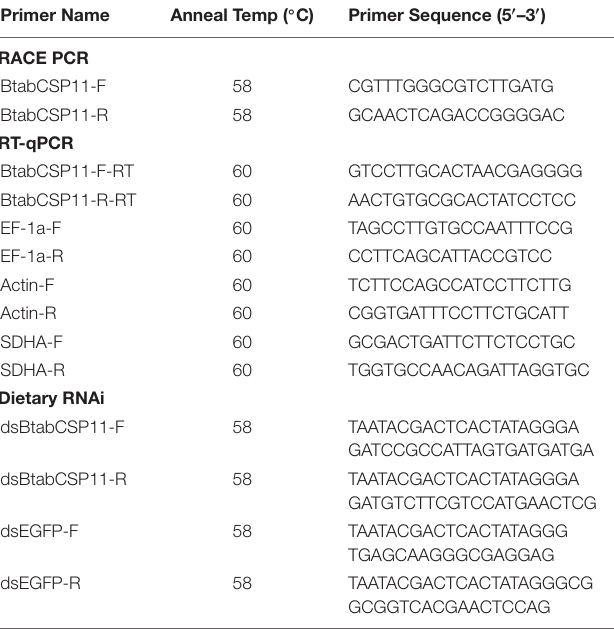
TABLE 1 | Primers used for this